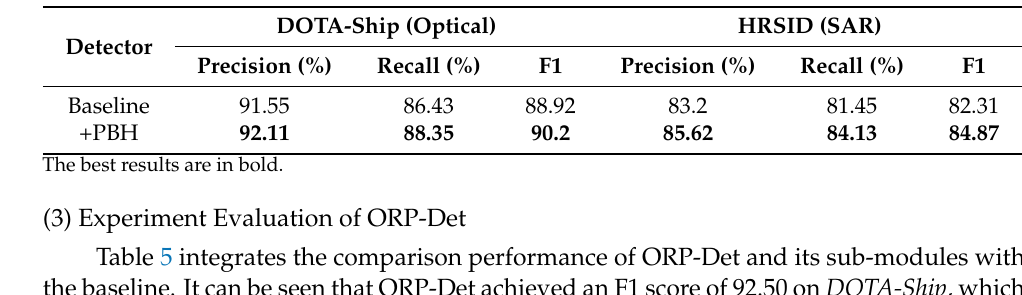
Table 4. Evaluation experiments for pairwise branch detection